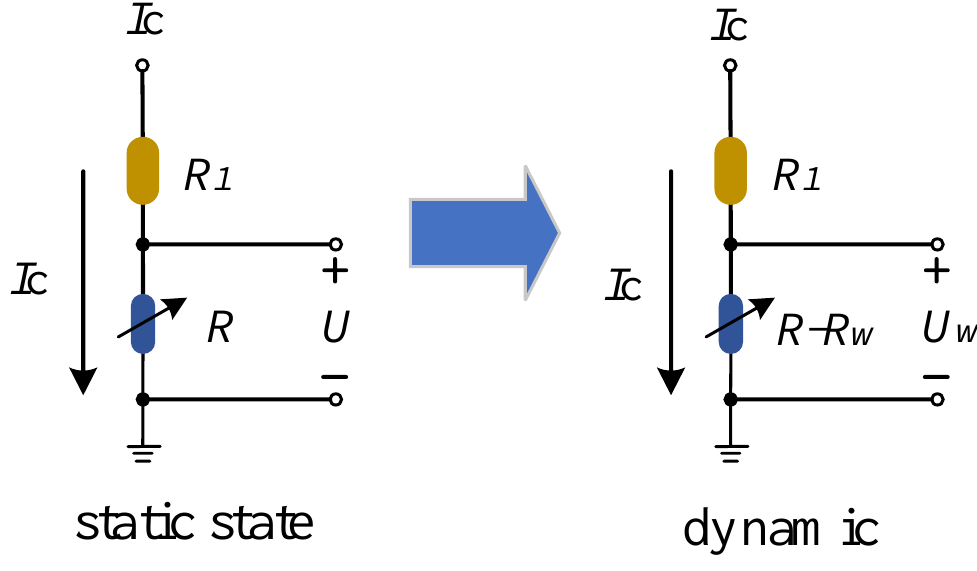
Figure 3. Constant current heating.